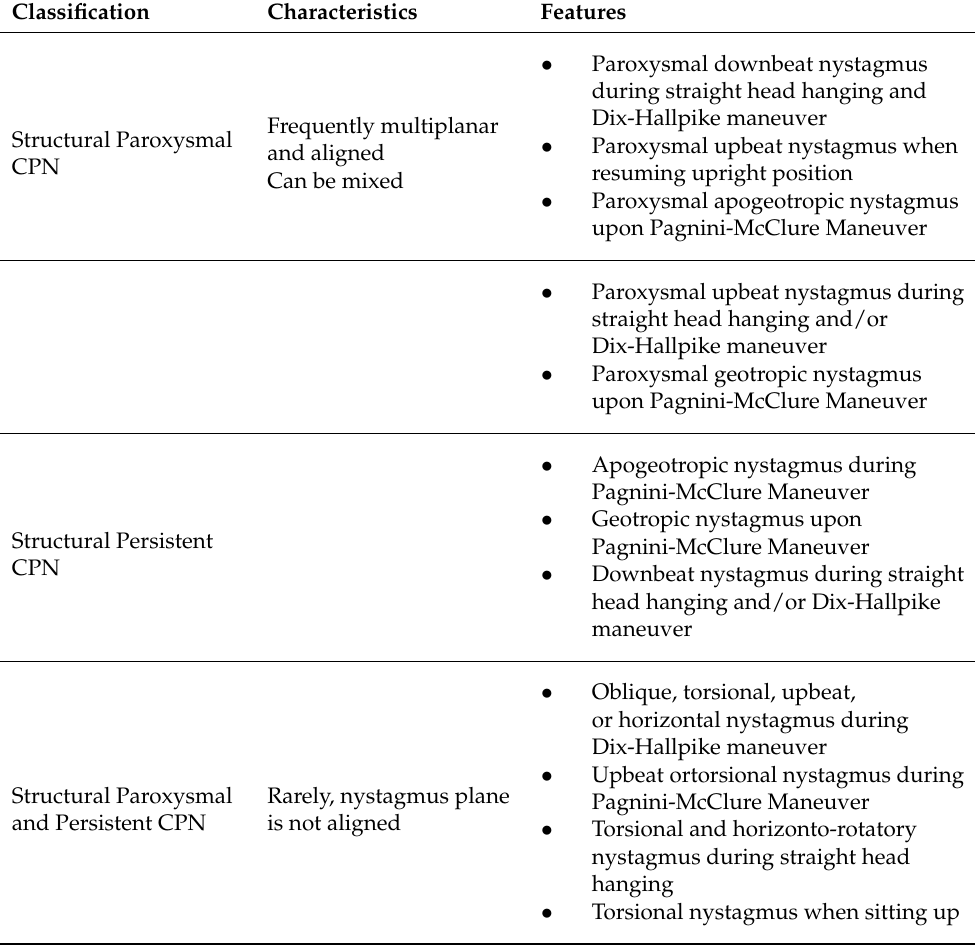
Table 1. Classification of central positional nystagmus based on